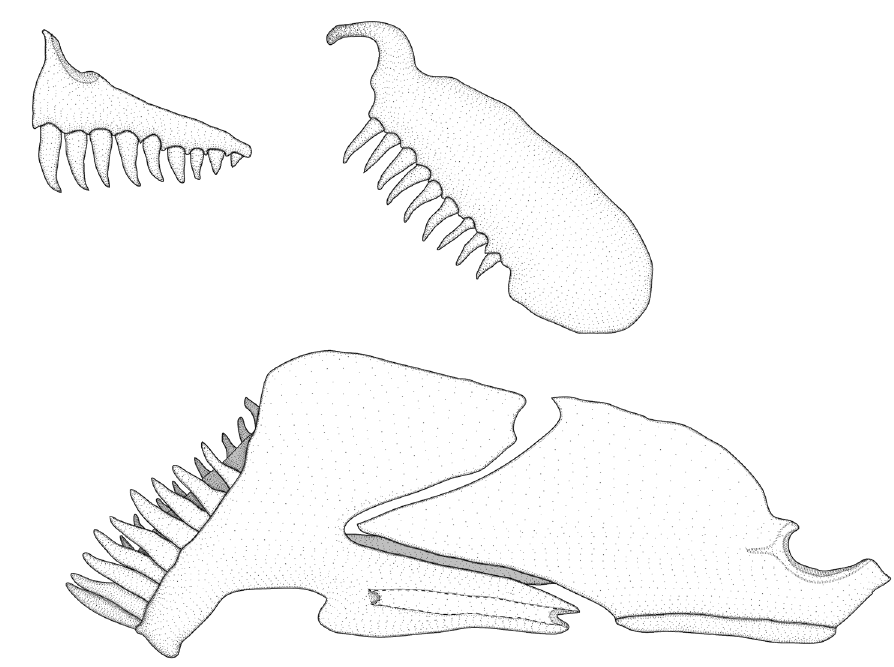
FIGURE 2 | Odontocharacidium varii , new species, USNM 270149, paratype, 15.8 mm SL, Venezuela, Río Negro Municipality, Río Orinoco. Lateral view of mandibular arch and dentition, flipped right side, anterior to